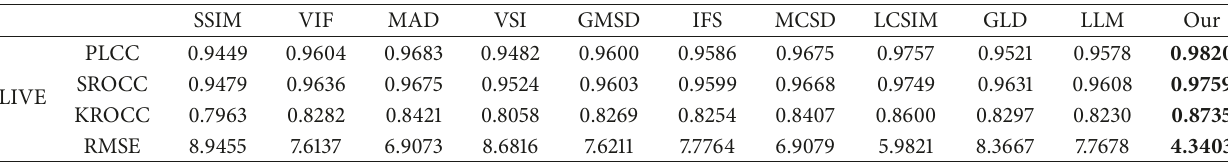
Table 3: Performance comparison on LIVE database.